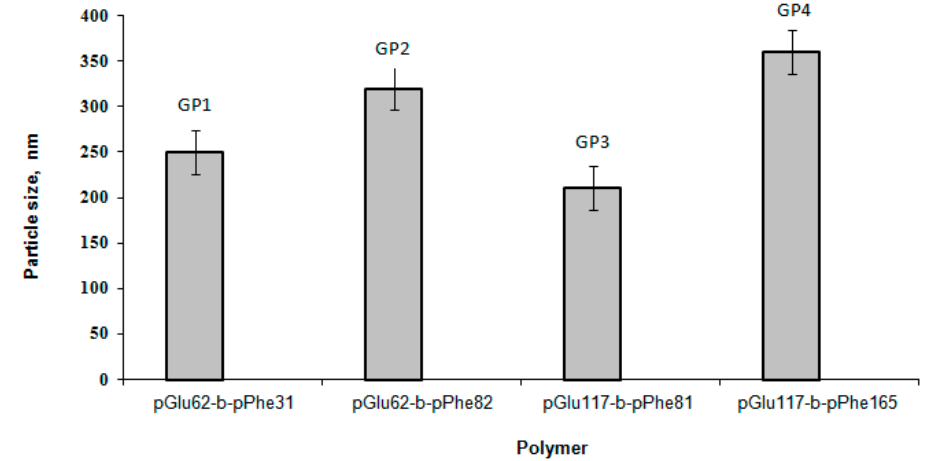
Figure 2. Effect of block length on particle size (particle concentration is 0.5 mg/mL, pH 8.4).